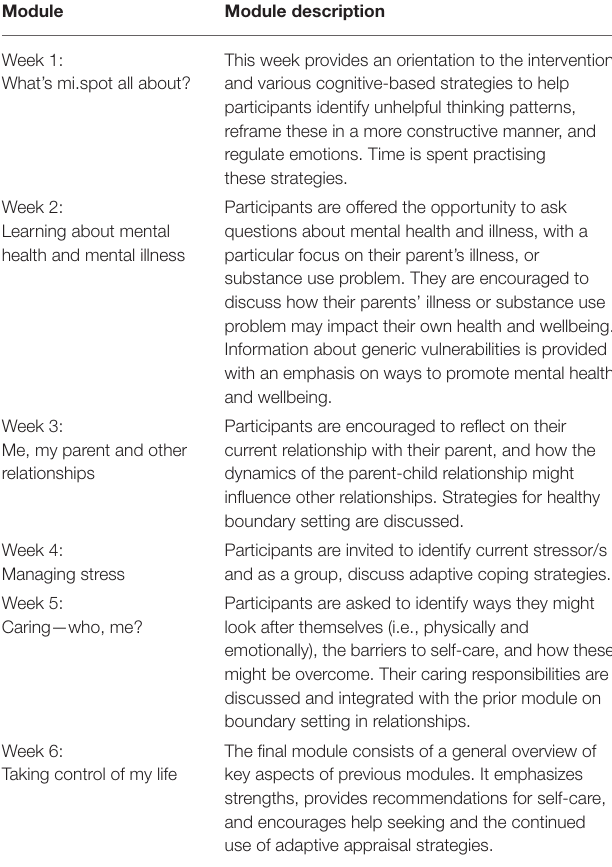
TABLE 2 | mi.spot weekly